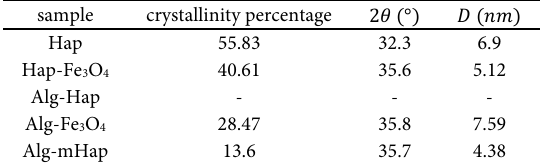
Table 1. Information on crystal size and crystallinity percentage of synthesized sample